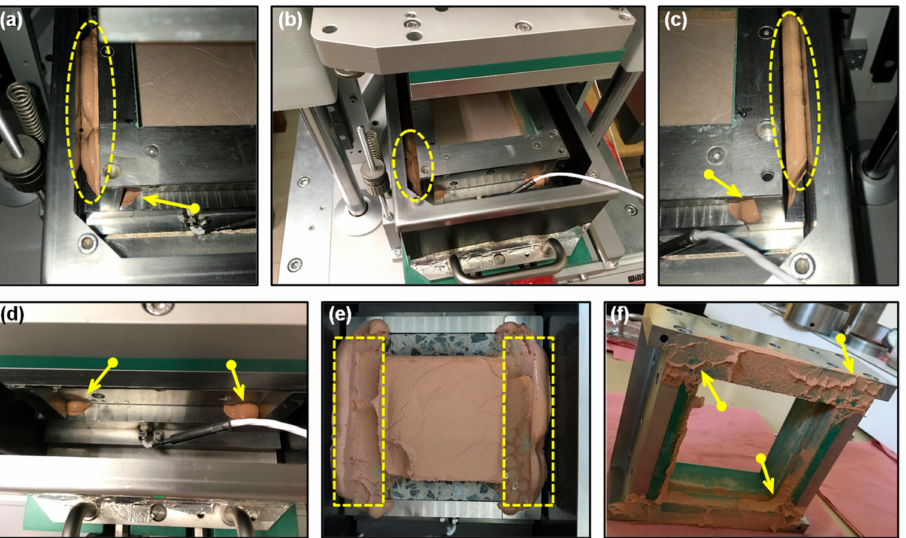
Figure 3. Improper sample preparation brings about soil specimen leakage from the space of the interface direct shear box: ( a ) leakage on the left of the shear box, ( b ) shear box and container, ( c ) leakage on the right of the shear box, ( d ) leakage in the front view, ( e ) soil sample without a good shape after dismantled and ( f ) soil leakage around upper part of the shear